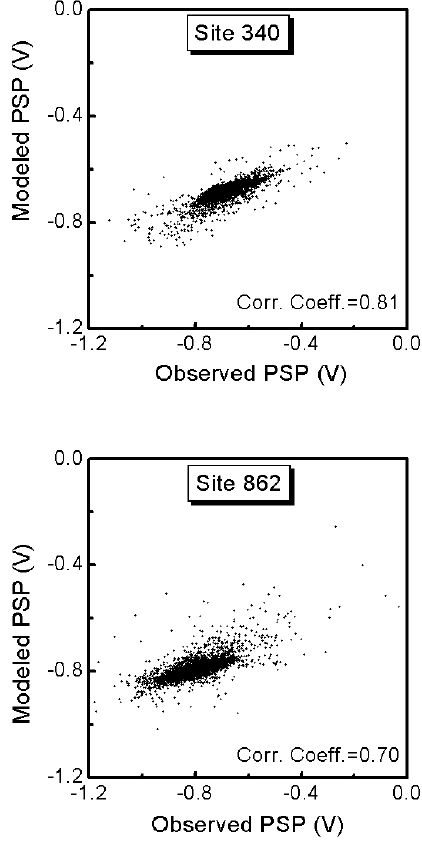
Fig. 13. Linear correlation between modelled and observed pipe-to- soil potential for (a) site 340 and (b) site 862 on the Norman Wells – Zama